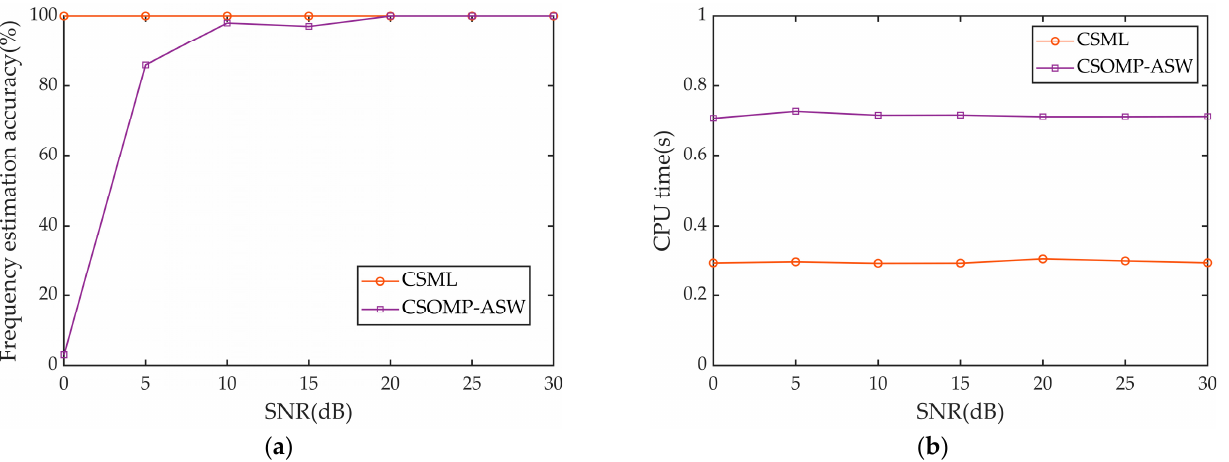
Figure 16. Performance of the two algorithms when estimating the frequency. ( a ) The frequency estimation accuracy of the two algorithms. ( b ) CPU time consumed by the two algorithms.